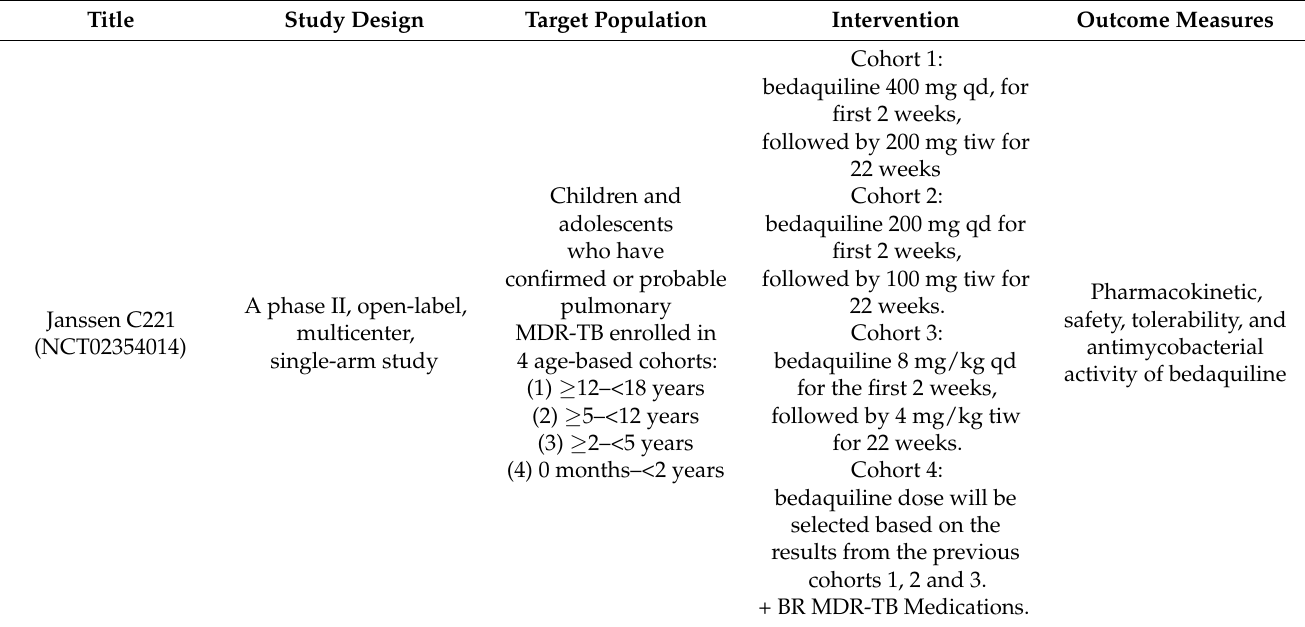
Table 4. Ongoing trials testing bedaquiline pharmakokinetic in children and adolescents (0–18 years old) with